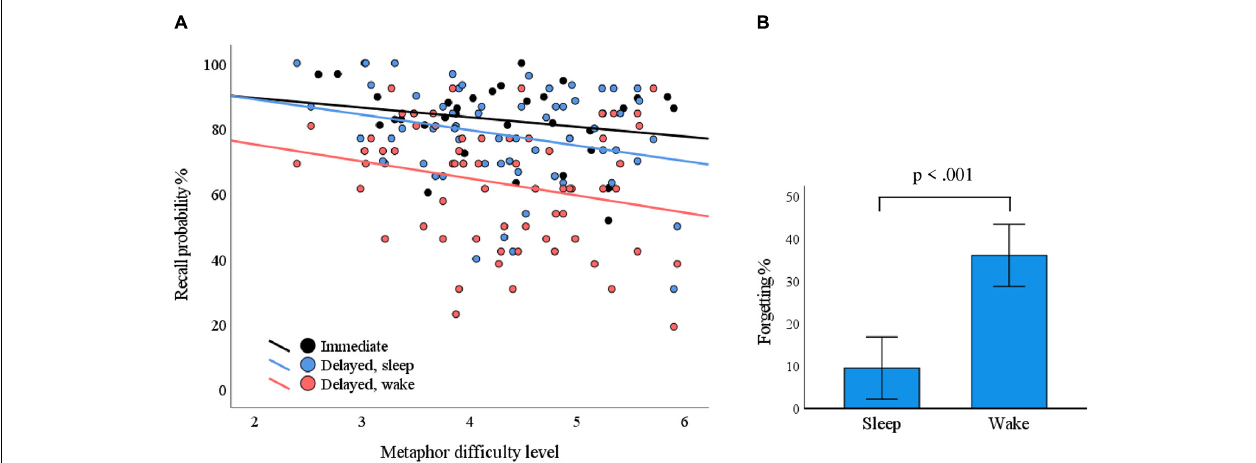
FIGURE 3 | The impact of metaphor difficulty and delay conditions on recall performance. (A) Each dot represents a metaphor. The probability for correct responses depended on the metaphor difficulty level in the delayed condition ( p = 0.023; blue line, sleep; red line, wake). (B) The delay over sleep associated with less forgetting as compared with the wake condition ( p <